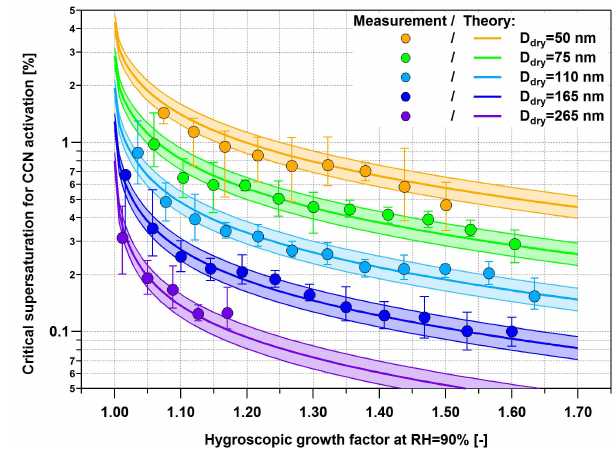
Fig. 8. Theoretical and measured SS crit values as a function of GF. The different colours represent the different dry diameters. The- oretical curves (solid lines) were calculated using κ -K ¨ ohler theory and assuming the surface tension of pure water at the point of activa- tion. The shading around the theoretical curves indicates the effect of varying the surface tension by ± 10% compared to that of pure water. The measured data points (filled circles) represent the super- saturation at which an activated fraction of 50% was measured for a certain dry diameter and growth factor. The error bars indicate the corresponding supersaturation range between 30% and 70% acti-